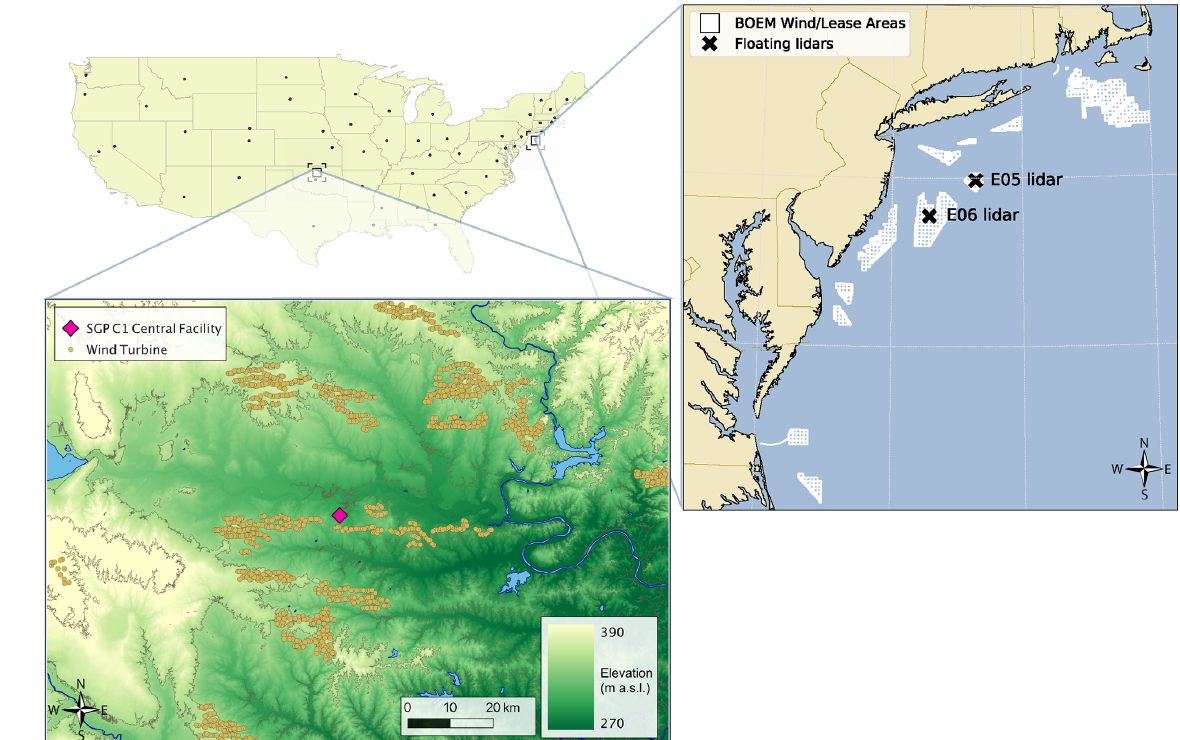
Figure 1. Map of the two sites considered in our validation analysis. Digital elevation model data courtesy of the U.S. Geological